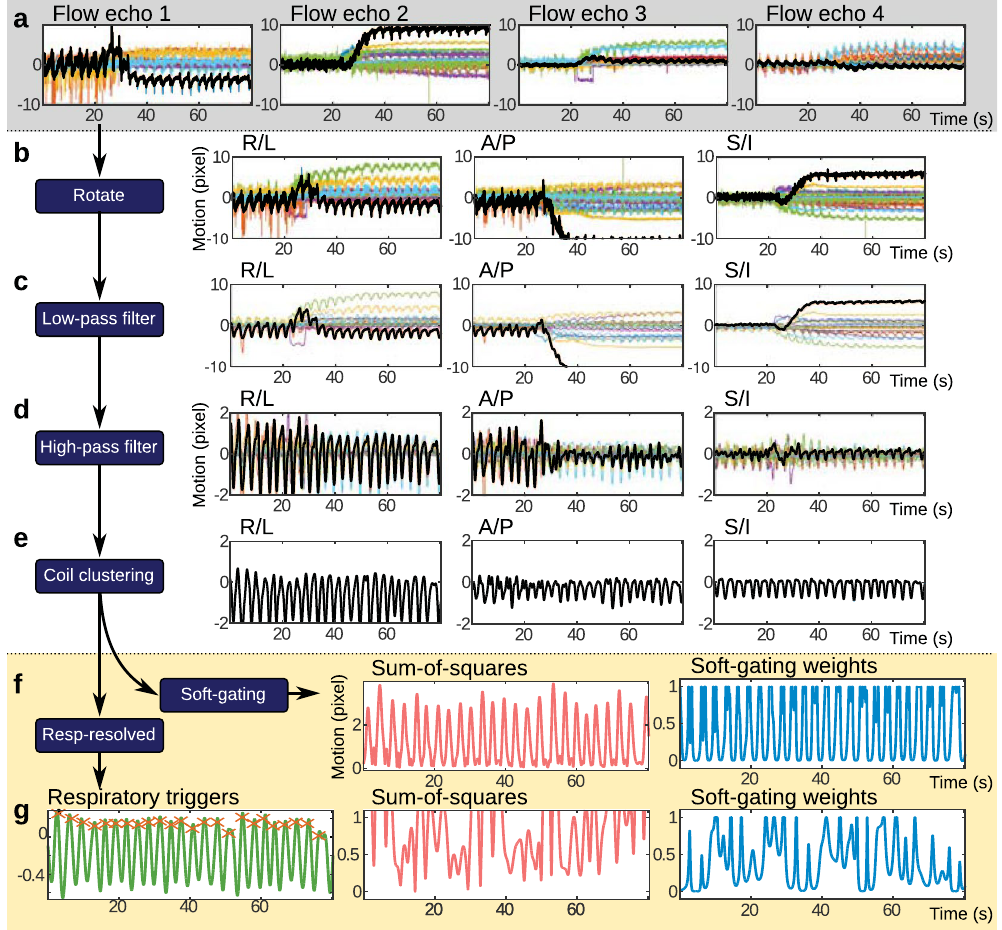
Figure 8. Processing of motion estimates for physiological signal monitoring. From the 4 different velocity- encoded echoes (4 flow echoes), 4 different directions of motion are measured using the Butterfly navigators and are plotted in terms of image pixels in ( a ). Each color represents a different channel from a 32-channel cardiac coil receiver. In ( b ), these estimates are rotated to the conventional right/left (R/L), anterior/posterior (A/P) and superior/inferior (S/I) directions. In ( c ), a low-pass filter tuned with a cut-off frequency based on the recorded cardiac rate is used to remove the cardiac signal and noise. In ( d ), a high-pass filter is applied to remove the low- frequency drifting that is partially attributed to the contrast administration. In ( e ), a coil-clustering algorithm is used to extract the dominate motion. Afterwards, the motion estimates can be directly used to compute soft- gating weights ( f ) or further processed for respiratory-resolved imaging ( g ). For respiratory-resolved imaging, the respiratory trigger points can be located and used to determine respiratory phases. Soft-gating weights based on residual patient motion from changing respiratory depth or bulk patient motion can then be